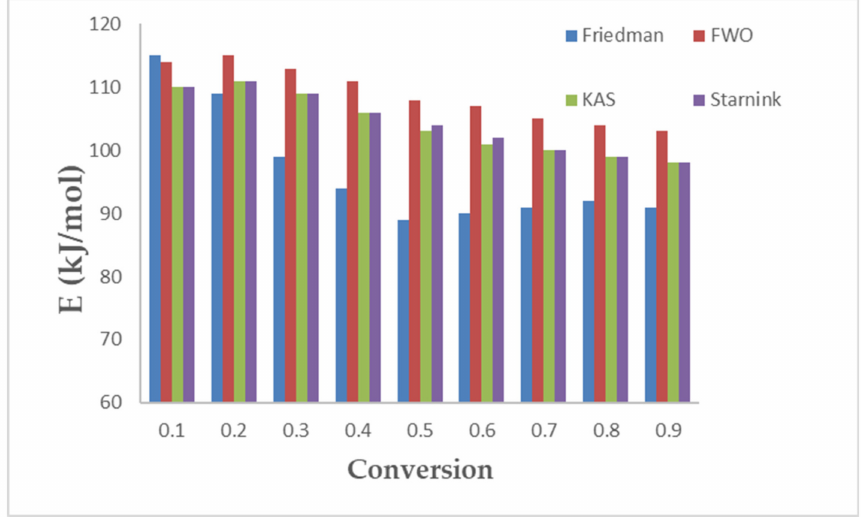
Figure 3. Activation energies for (Friedman, FWO, KAS, and Starink) of PLA